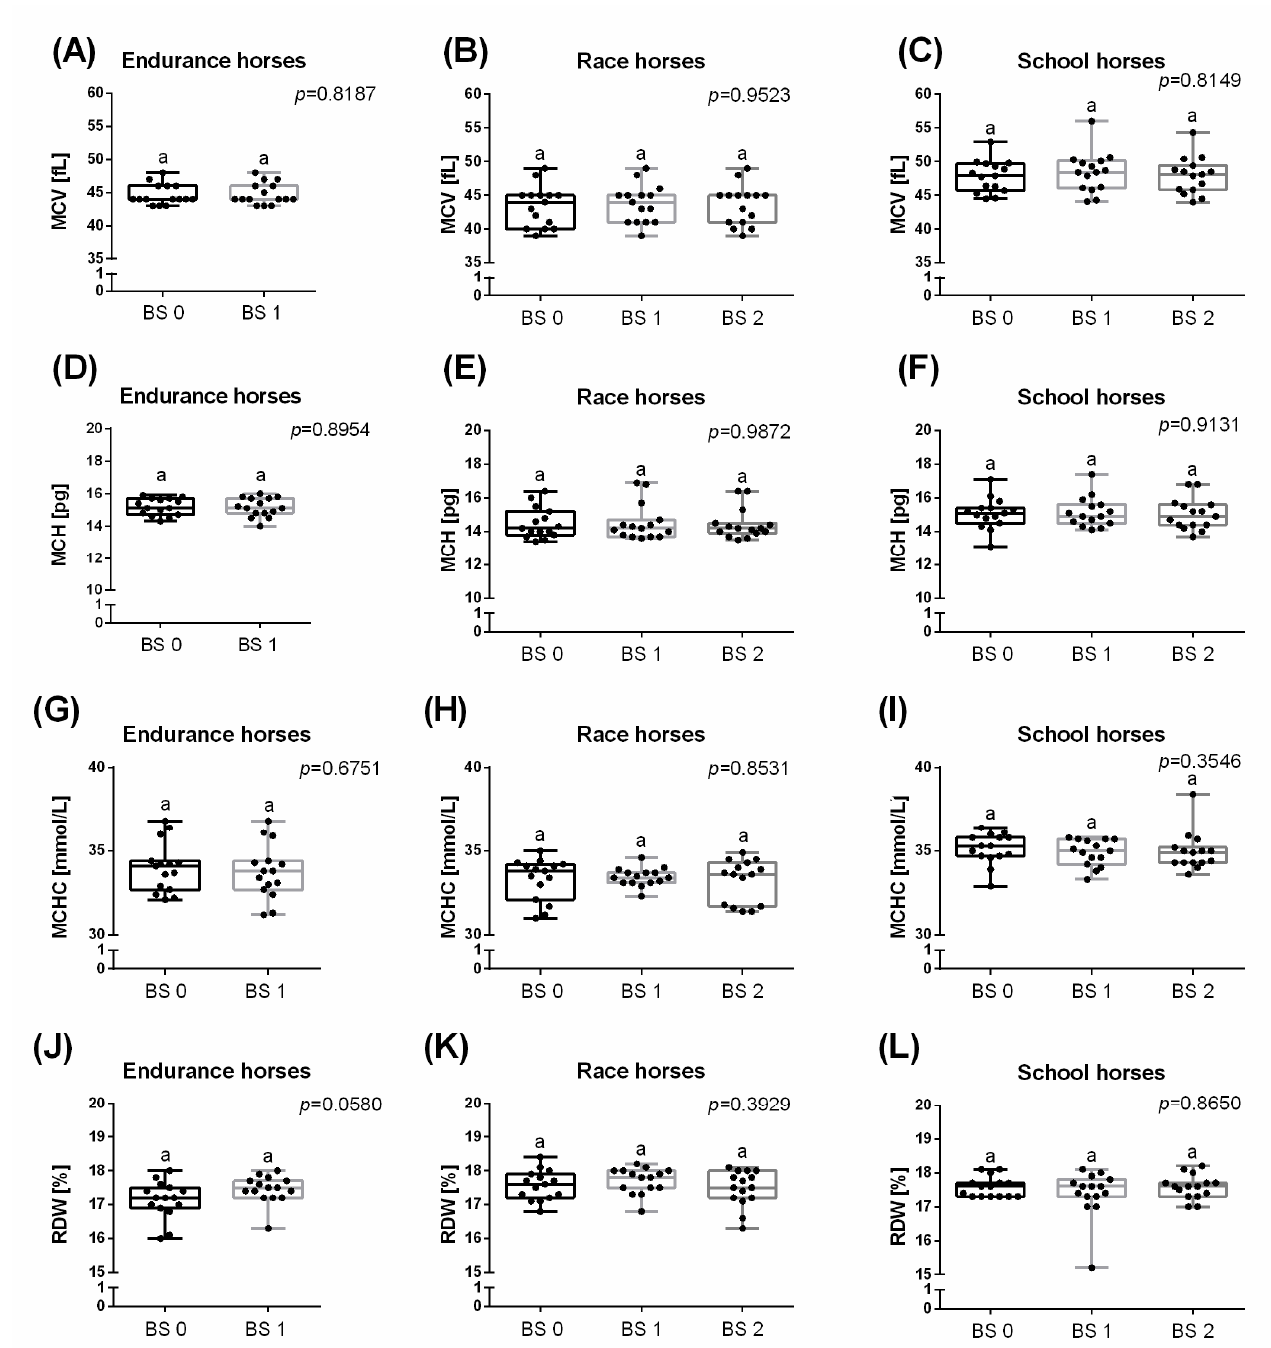
Figure 2. Selected hematological parameters (mean + SD), mean corpuscular volume (MCV) ( A – C ); mean corpuscular hemoglobin (MCH) ( D – F ); mean corpuscular hemoglobin concentration (MCHC) ( G – I ); red cell distribution width (RDW) ( J – L ), measured before training (BS 0; individual values marked with dots), immediately after training (BS 1; individual values marked with squares) and 30 min after training (BS 2; individual values marked with triangles) in endurance horses ( A , D , G , J ), race horses ( B , E , H , K ) and school horses ( C , F , I , L ). Lower case letters indicate differences between BSs for p < 0.05.